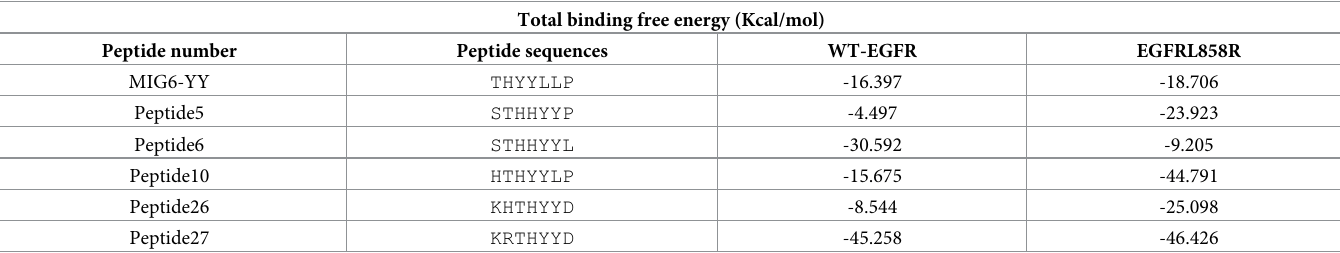
Table 2. Total binding free energies of WT-EGFR and EGFRL858R in complex to MIG6-YY, Peptides 5, 6, 10, 26 and 27 obtained by MM-PBSA